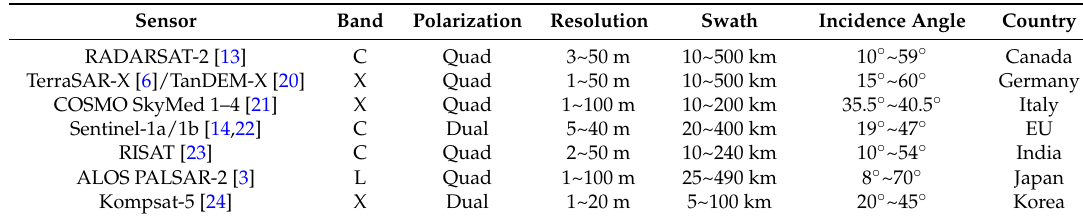
Table 1. List of current typical spaceborne synthetic aperture radar (SAR) systems.